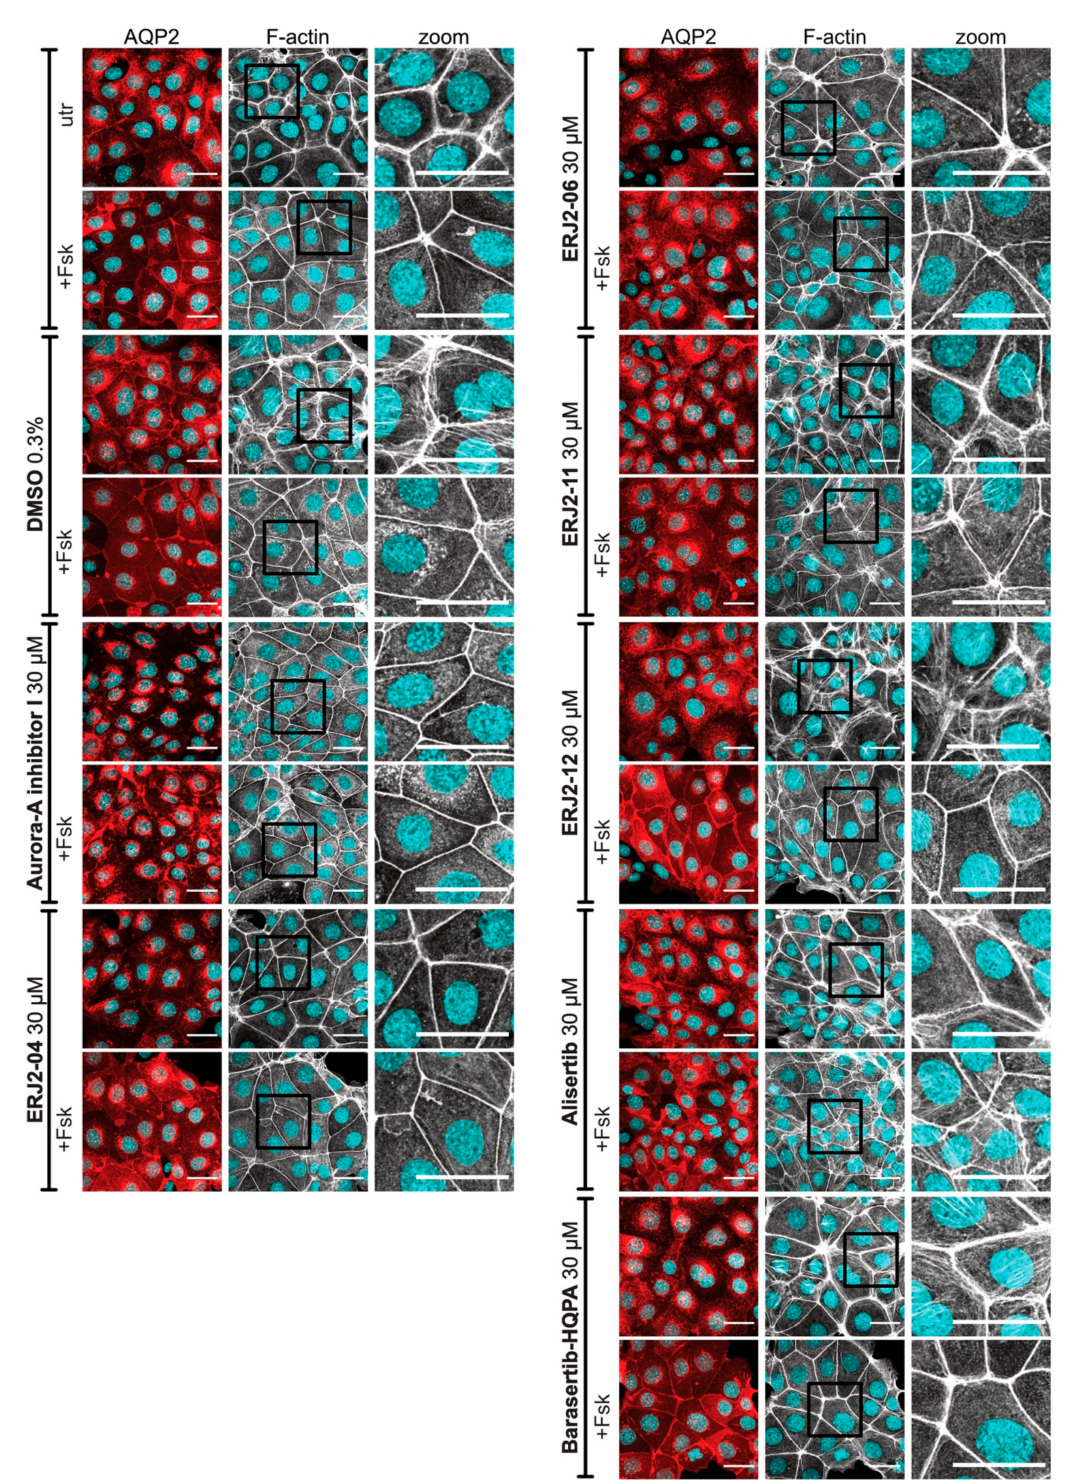
Figure 8. AURKA inhibitors affect the organization of actin stress fibers in MCD4 cells. MCD4 cells were left untreated (utr) or treated with DMSO (0.3%, 1 h) or compound (30 µ M, 1 h) alone or in com- bination with forskolin (Fsk; 30 µ M, 30 min). AQP2 was detected by immunofluorescence microscopy using specific primary antibody (AQP2, E-2) and Cy3-coupled anti-mouse secondary antibody (red). Filamentous (F-)actin was stained using an iFluor 488-conjugated phalloidin (grey). Nuclei were stained with DAPI (cyan). Shown are representative images of three independent experiments; scale bar 30 µ m. Magnified views (zoom) of actin stress fibers are from the indicated